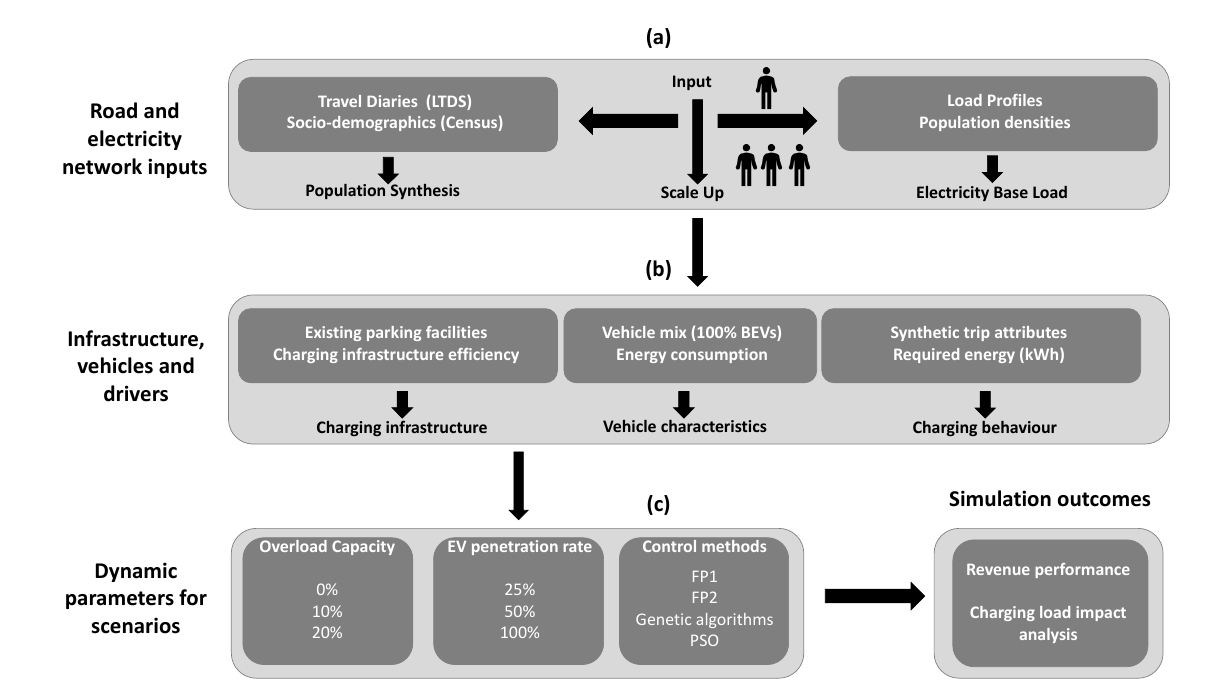
Figure 7. Simulation framework for charging and V2G coordination. The three levels capture ( a ) the synthetic approach to building a representative demand for travel and energy, ( b ) the technology and behavioural assumptions and ( c ) the dynamic parameters that were evaluated under different scenarios.